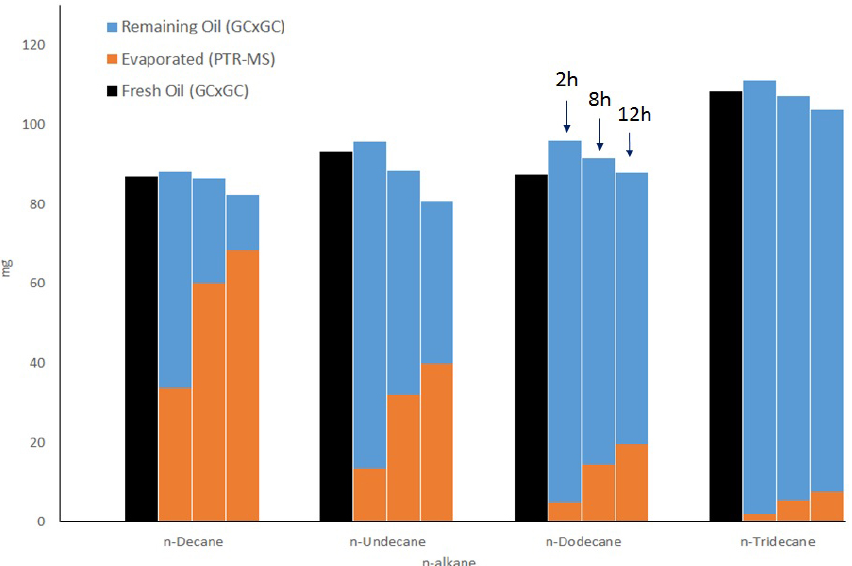
Figure 8. n -Alkane mass in fresh oil as measured by GC × GC and n -alkanes at different evaporation times (2, 8 and 12h) as measured by PTR-MS (gas phase) and remaining in the oil as measured using GC × GC (liquid phase). The sum of evaporated and remaining n -decane, n -undecane, n -dodecane and n -tridecane is in good agreement with the amount in the fresh oil. Alkanes more volatile than n -decane were not observed quantitatively by the GC × GC analysis. Table 4. Potential bias of n -alkanes concentrations estimated with the algorithm vs. experimental concentrations indicated in Table S2. Bias (%) at three concentration levels. n -alkanes in the mixture. Experimental Algorithm Bias Experimental Algorithm Bias Experimental